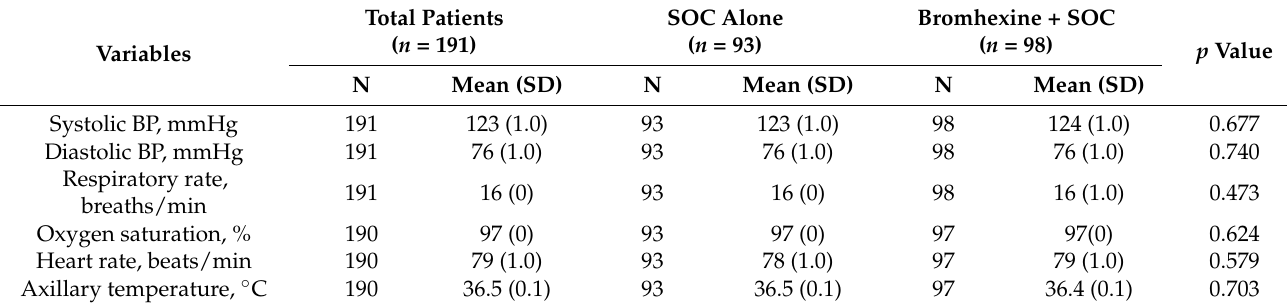
Table 2. Data of physical examination in the two study